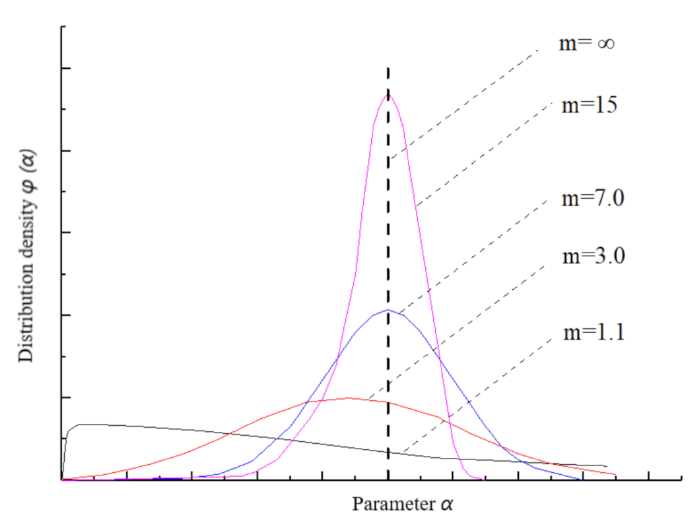
Figure 1. The primitive property distribution of different uniformity